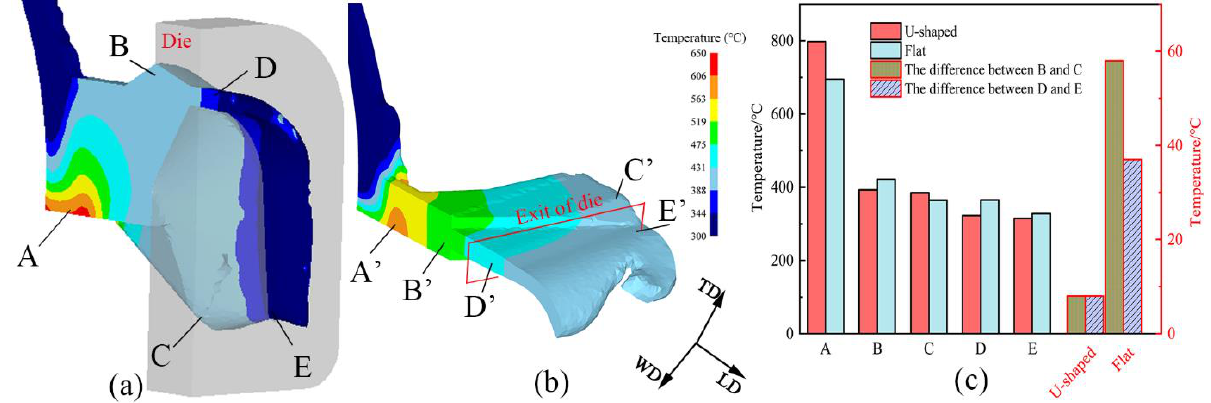
Figure 4. Distribution of simulated temperature of ( a ) U-Shaped and ( b ) Flat strips; ( c ) Temperature value and temperature difference.